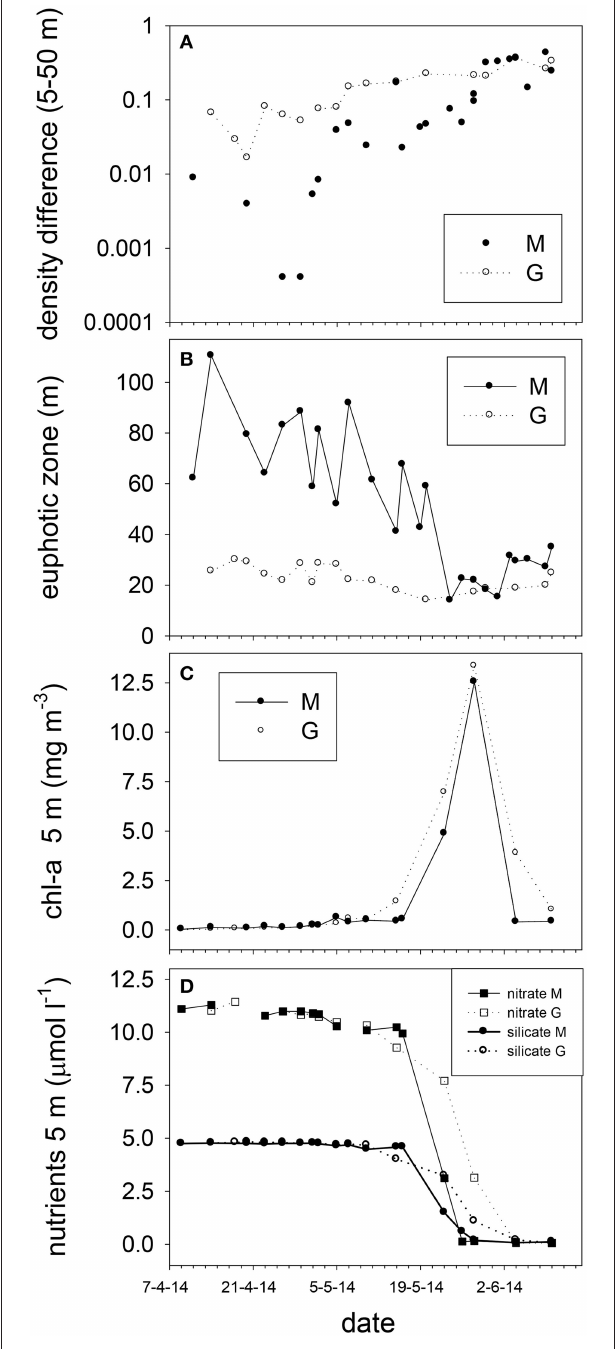
FIGURE 5 | Stratification strength as differences in potential density between 5 and 50m (A), (B) euphotic zone depth, (C) surface chlorophyll-a (5 m), and (D) nitrate and silicate concentrations (5 m) at stations M and G from April to June 2014.